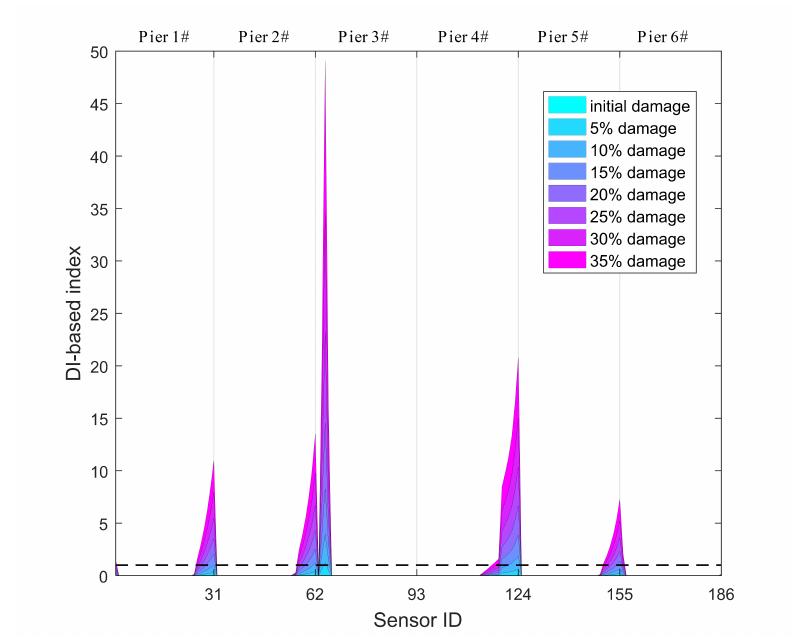
Figure 15. Identification results for Damage I using WPE-based method for all six piers.